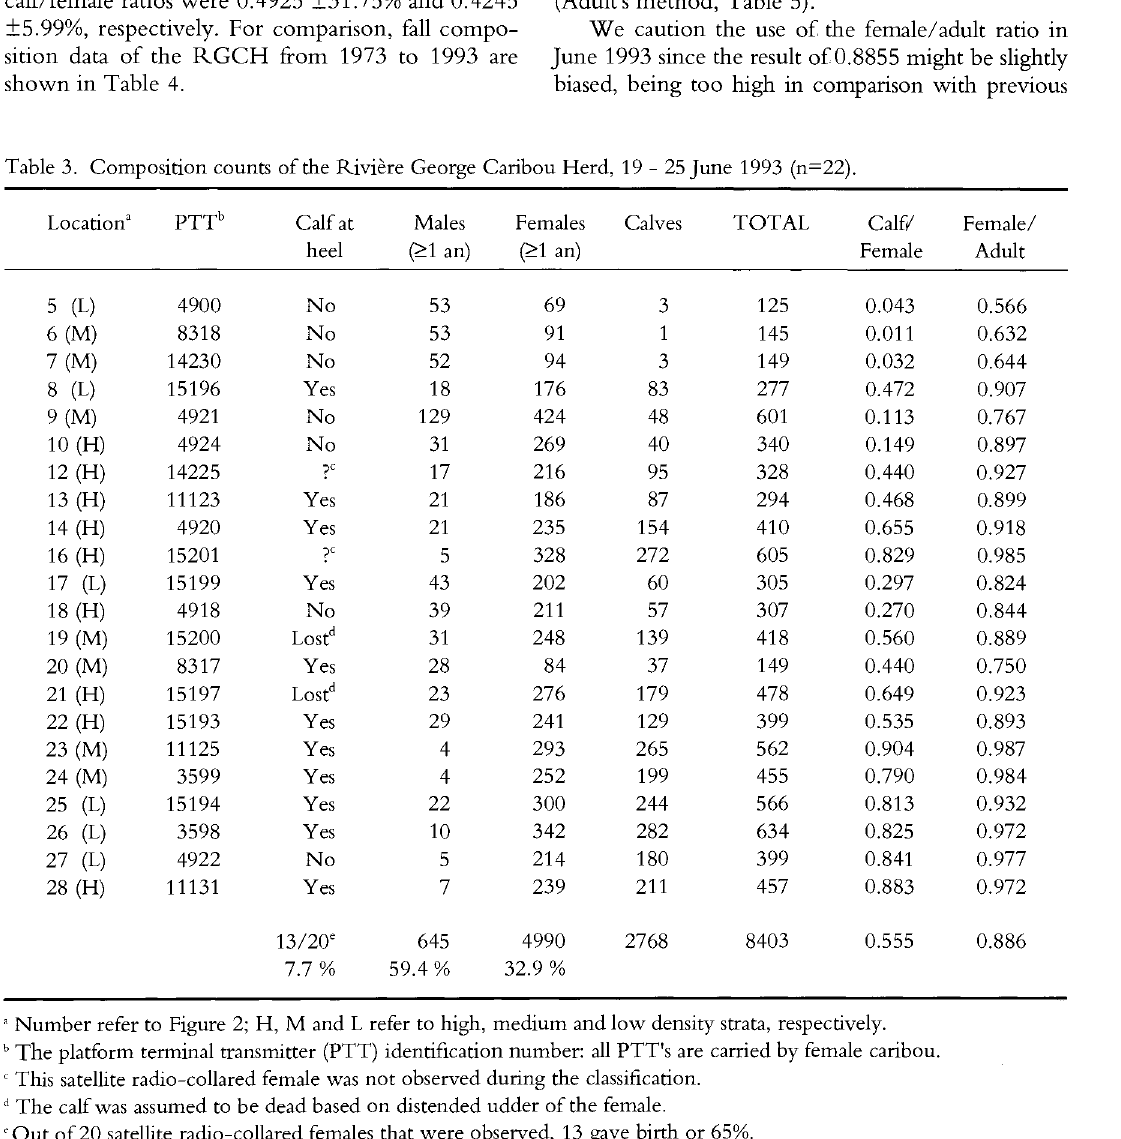
Table 3. Composition counts of the Rivière George Caribou Herd, 19 - 25 June 1993 (n—22).